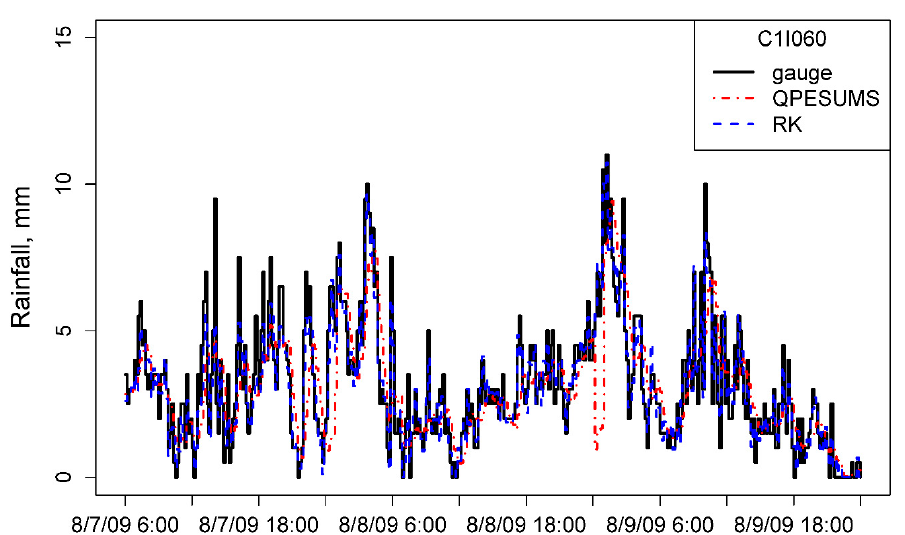
Figure 8. Hyetographs at station C1I060 showing the complete time variations in rainfall data from RK (adjusted), QPESUMS (unadjusted), and gauges for the event of Typhoon Morakot. Remote Sens. 2020 , 12 , x FOR PEER REVIEW The hyetographs covering the event period of Typhoon Morakot at station C1I060 are shown in Figure 8. The plots include the interpolated results from the RK and merging methods. Observations